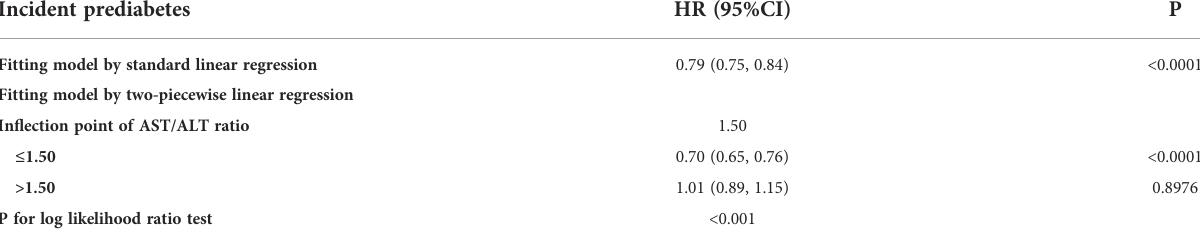
TABLE 6 The result of two-piecewise linear regression model. Incident prediabetes